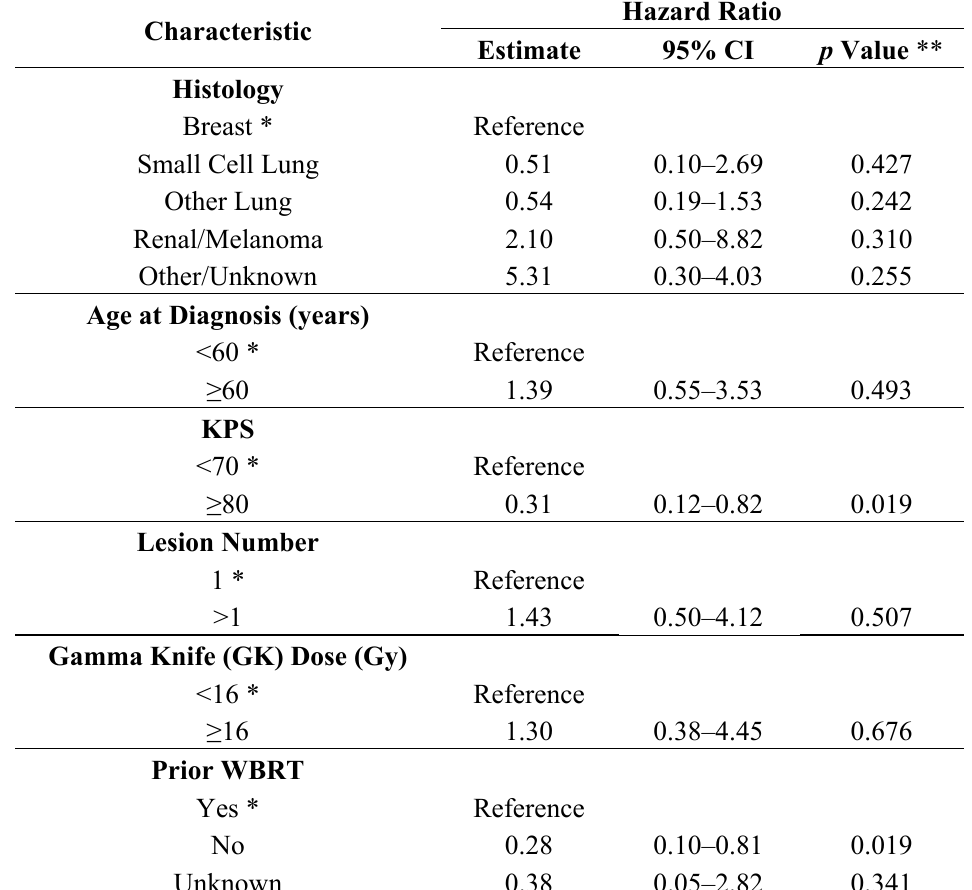
Table 3. Multivariate analysis of median survival. Prior whole brain radiation therapy and Karnofsky performance score (KPS) were statistically significant predictors of